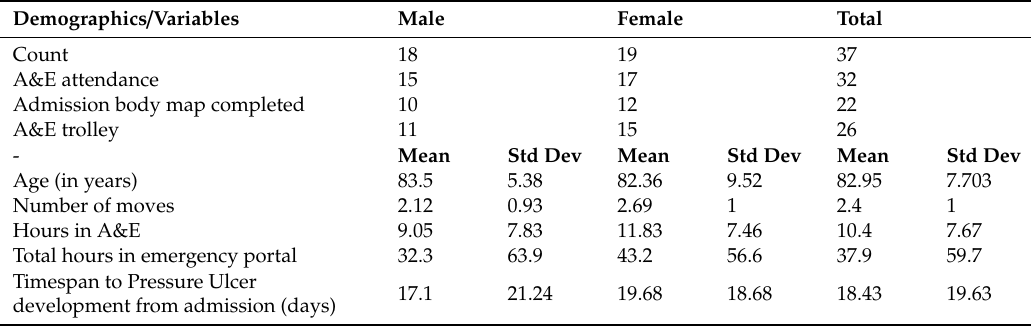
Figure 1. Age distribution. Table 2. Overview of the demographics and admission variables included in the